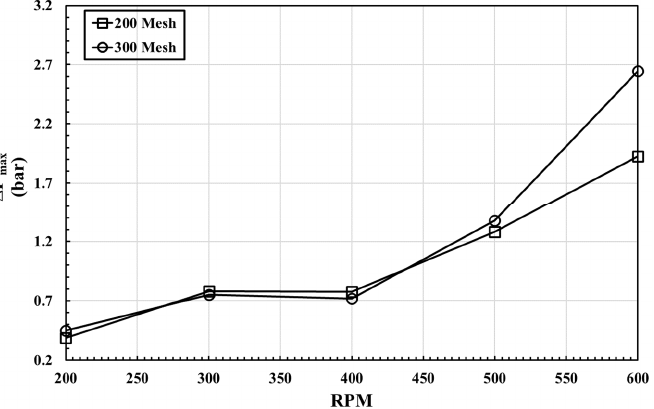
Figure 23. Variation of maximum pressure drop with piston speed for 200 and 300 mesh regenera- tors.